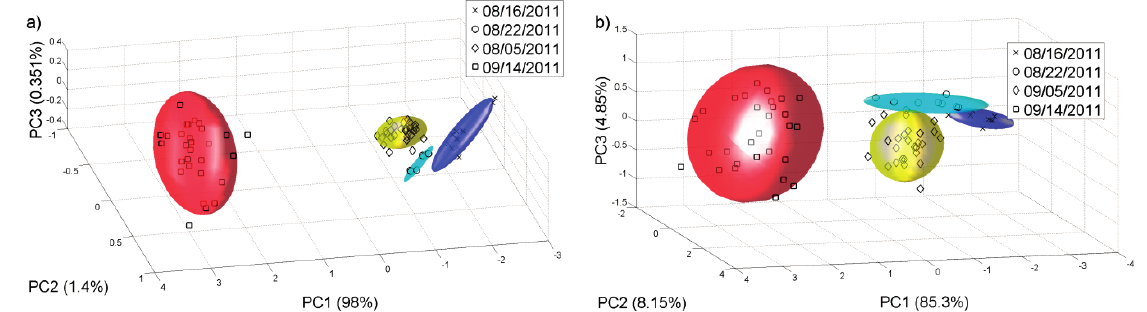
Figure 6. PCA plot for different grades of grape ripening in 2011. ( a ) Chenin Blanc; ( b ) Barbera.